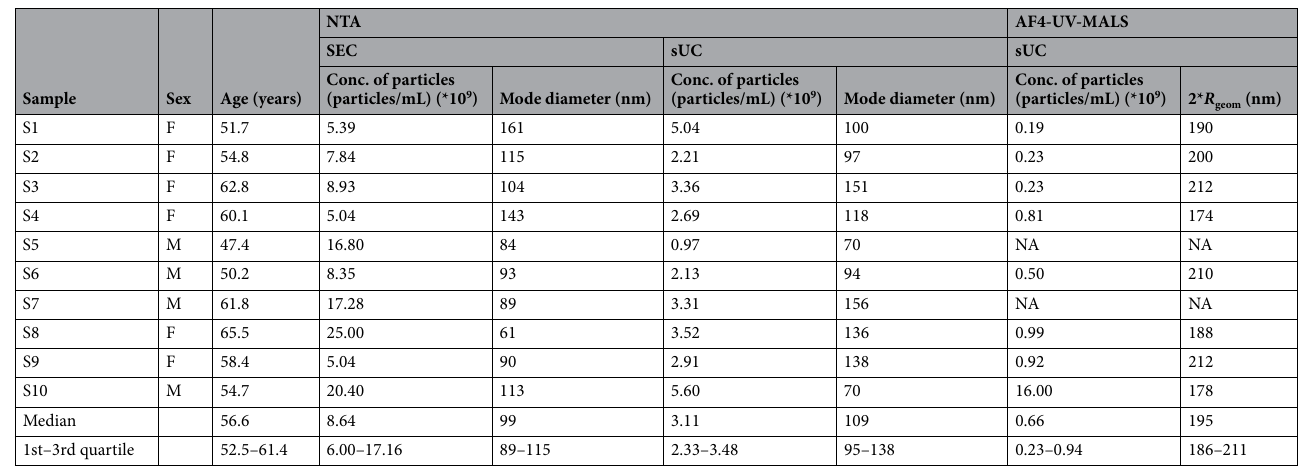
Table 1. Concentration and size of nanoparticles, enriched by SEC or sUC, as measured by NTA and AF4- UV-MALS. NTA nanoparticle tracking analysis, AF4-UV-MALS asymmetrical flow field-flow fractionation with ultraviolet and multi-angle light scattering detectors, SEC size exclusion chromatography, sUC ultracentrifugation with sucrose cushion, R geom geometric